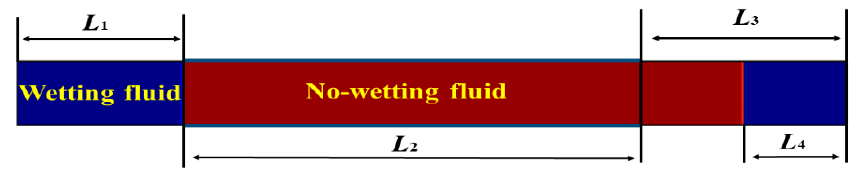
Figure 1. Schematic figure of capillary imbibition.